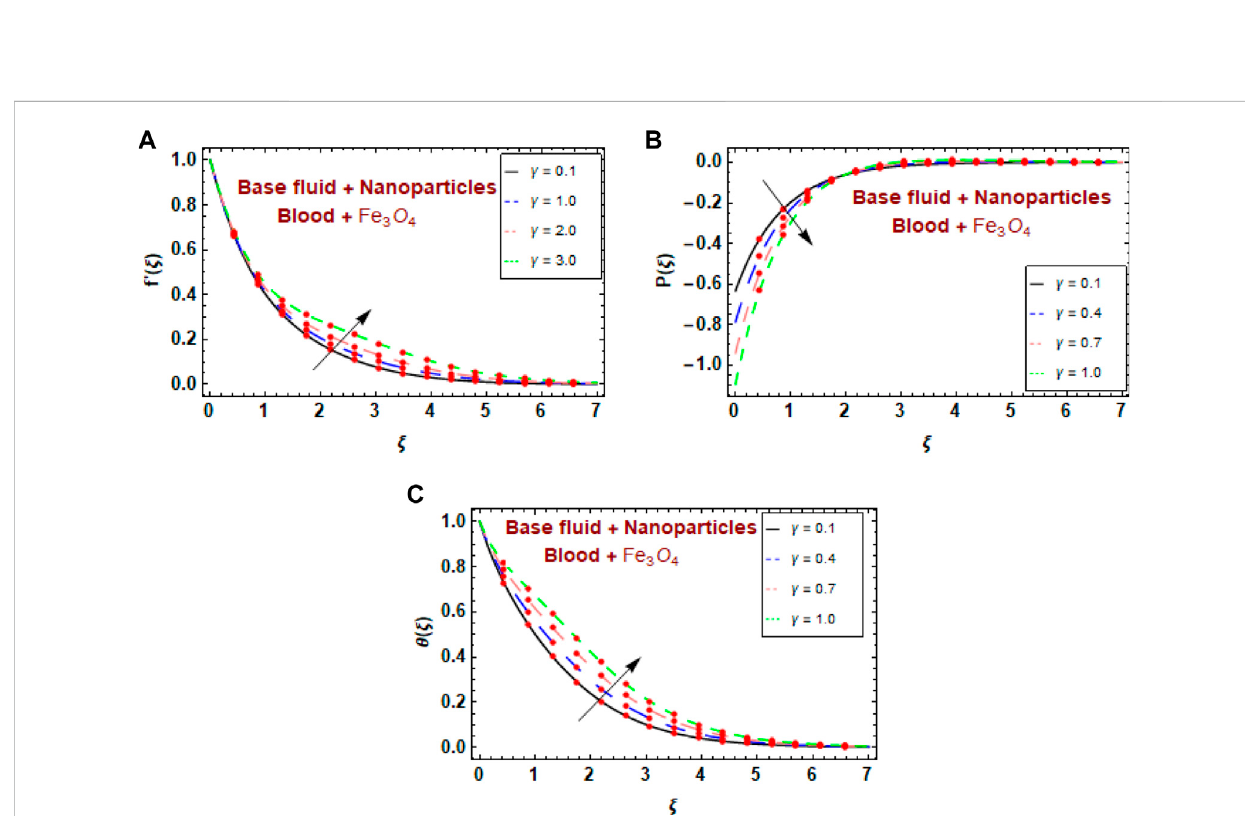
FIGURE 4 (A – C) Variations in f ′ ( ξ ) , p ( ξ ) , and θ ( ξ ) for distinct numbers of γ .